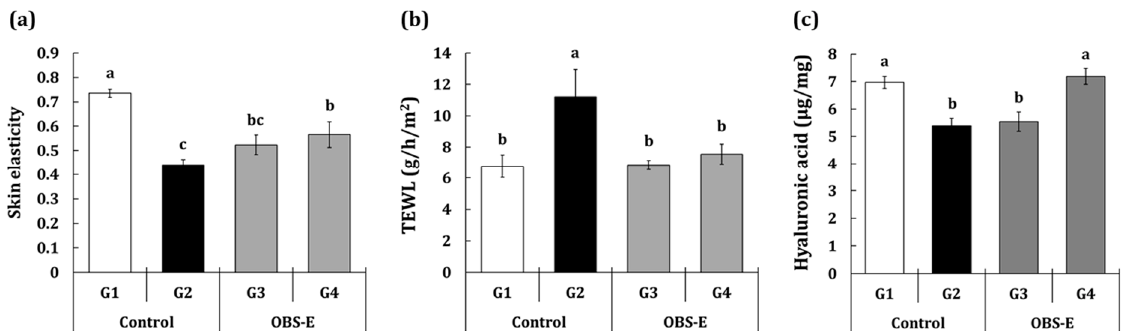
Figure 4. Effect of oral administration of OBS-E on ( a ) skin elasticity, ( b ) Transepidermal water loss, and ( c ) hyaluronic acid. G1, non-irradiated control group administered saline; G2, UVB-irradiated control group administered saline; G3 and G4, UVB-irradiated test agent groups administered OBS-E at doses of 50 and 200 mg/kg BW/day, respectively. Different superscripts indicate significant difference among groups by Duncan’s multiple range test ( p < 0.05).